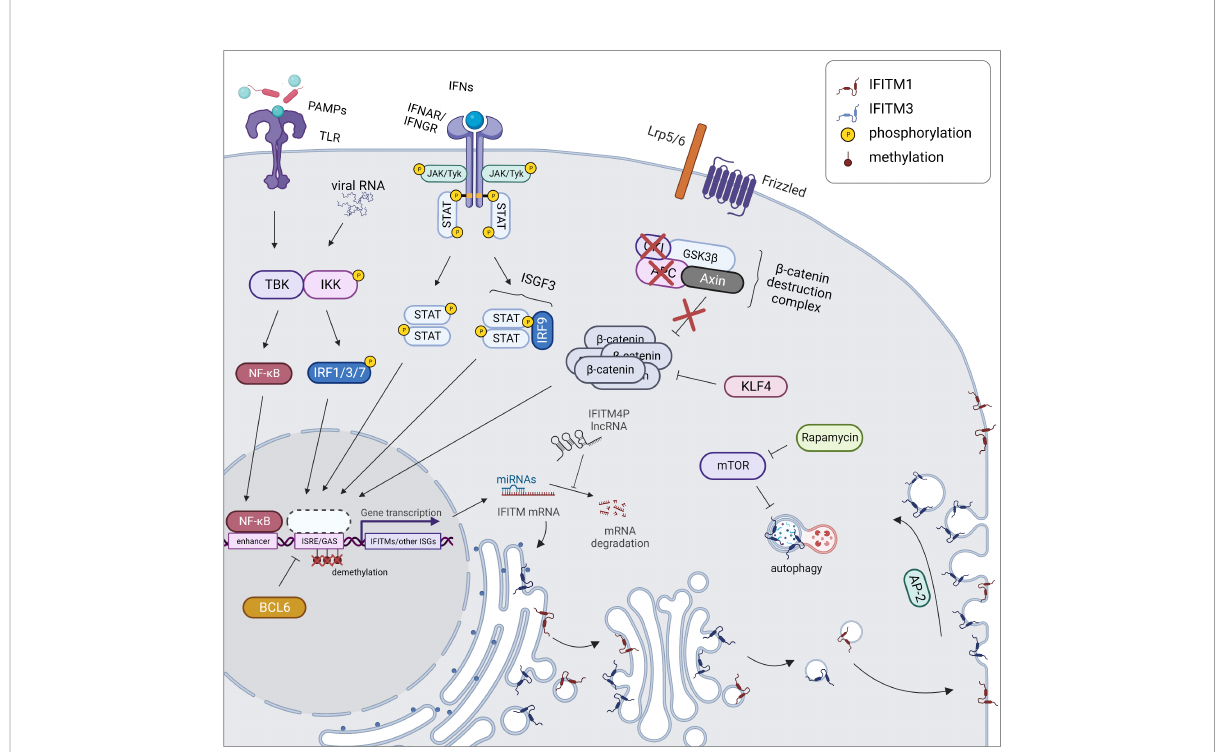
FIGURE 2 Regulation of expression and localization of IFITM proteins. During an in fl ammatory response, IFITM gene expression is triggered together with other ISGs by STAT/IRF signaling pathways. In cancer cells, the expression of IFITMs is linked with activation of the Wnt/ b -catenin signaling pathway which is caused by disruption of b -catenin destruction complex (APC, CKI loss of function). IFITM expression is also controlled by KLF4 inhibiting Wnt/ b -catenin signaling. Another cause of increased IFITM level in tumors is promoter demethylation, on the other hand, BCL6 causes transcriptional repression of IFITM3 gene by binding to its promoter. Posttranscription regulation of IFITMs includes miRNA-directed cleavage of IFITM mRNA, which can be prevented by IFITM4P lncRNA acting as a decoy for miRNAs. Posttranslational regulation comprises a proper IFITM localization. While IFITM1 (red) is maintained in the plasma membrane, IFITM3 (blue) is endocytosed into endosomes by AP-2 recognizing its YEML motif. IFITM3 protein turnover is controlled by autophagy. Created with